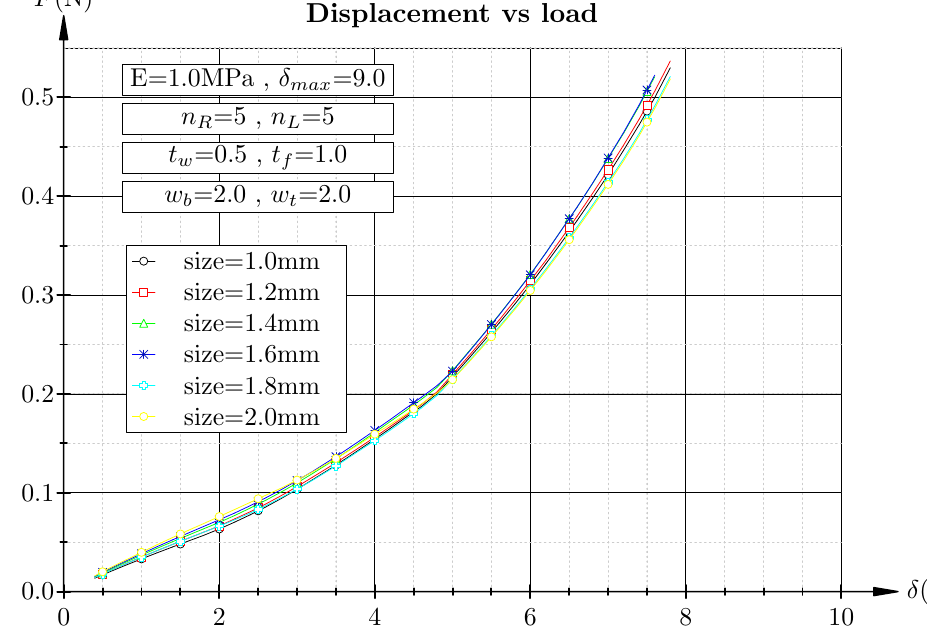
Figure 7. Mesh size sensitivity analysis: for a specific geometrical configuration, it is visible that the force-displacement curves obtaining compressing the stent varies only reasonably slightly within different